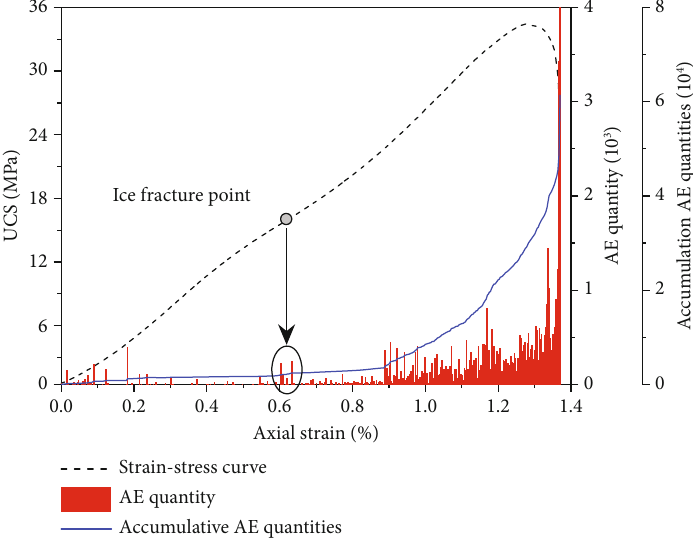
Figure 5: Acoustic emission characteristics of specimen at T = − 30 ° C